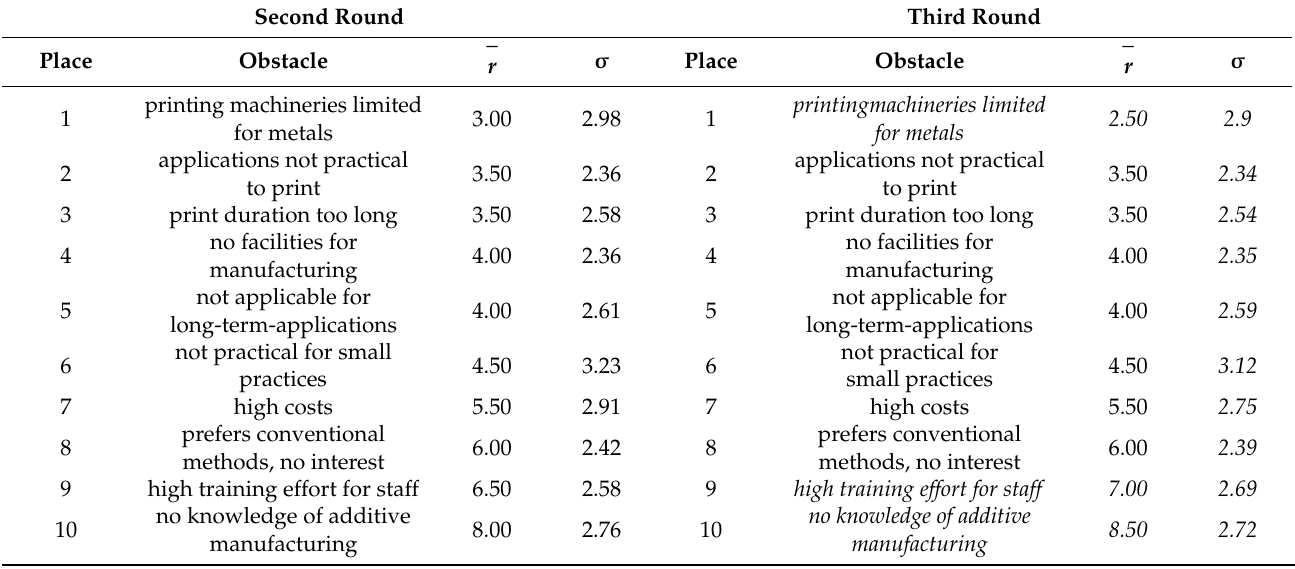
Table 2. Ranked obstacles of second and third survey